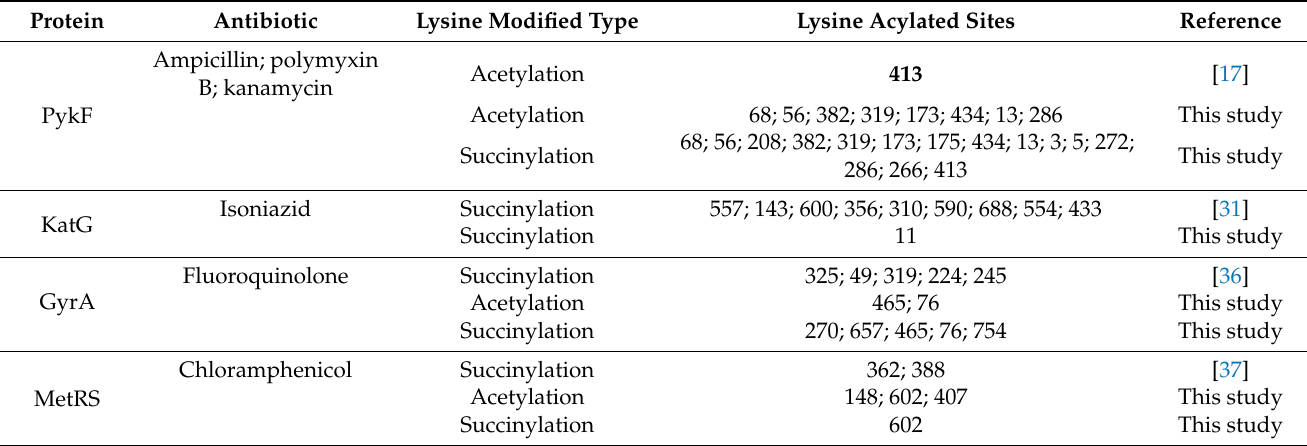
Table 1. The PTMs of AMR proteins in previous reports and in this